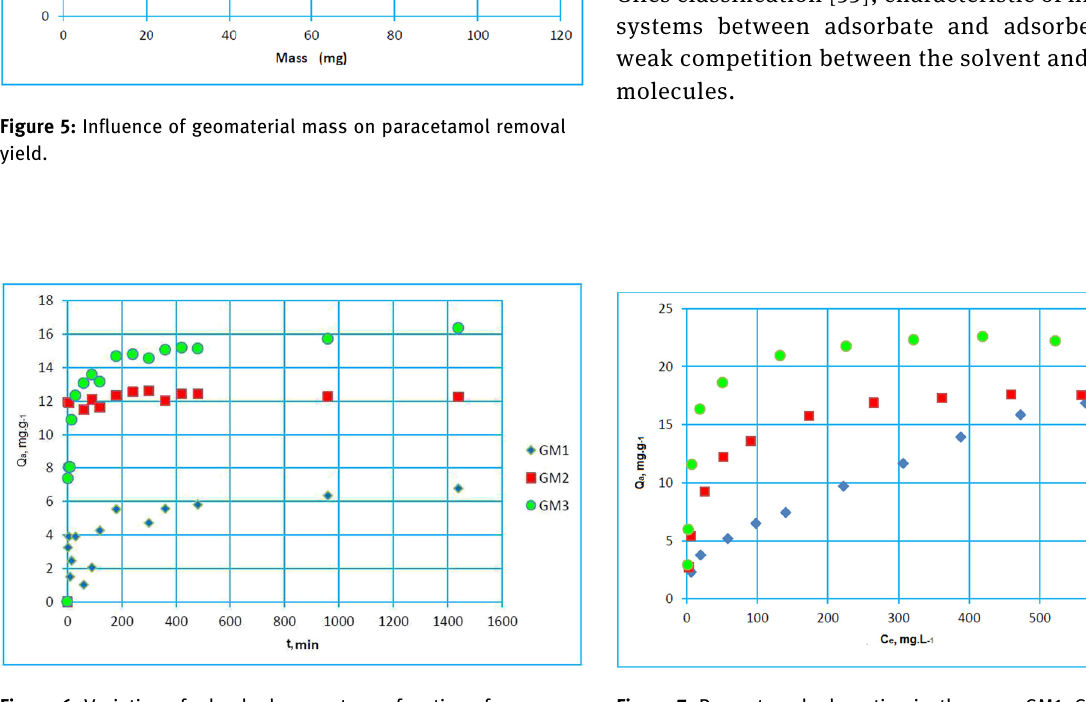
Figure 6: Variation of adsorbed amount as a function of contact time.